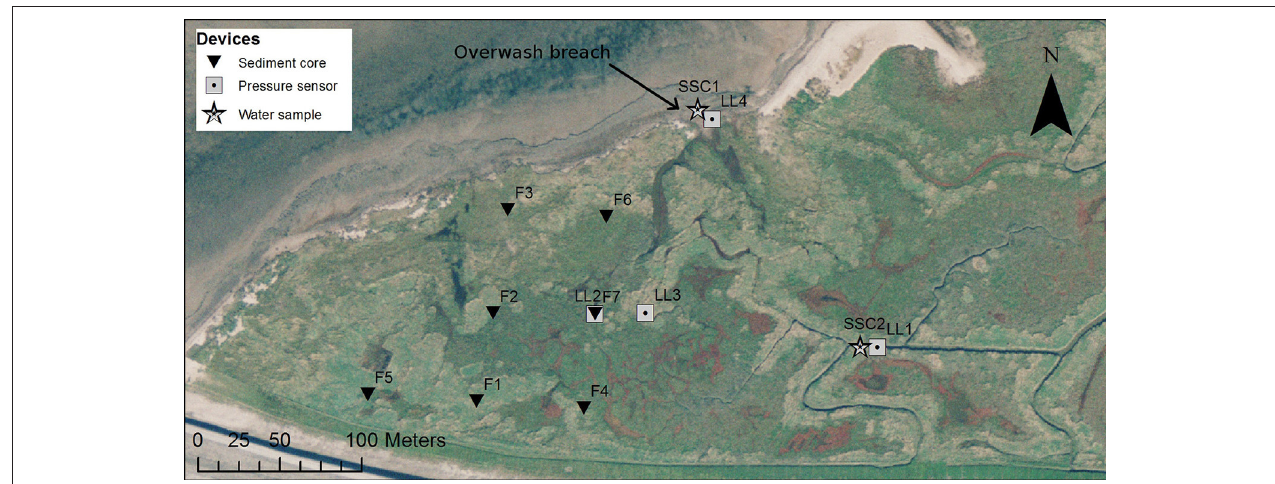
FIGURE 2 | Aerial photograph (from 2010) of the western part of the Oldsumer foreland and locations of sediment cores (F1 to F7), deployed pressure sensors (LL1 to LL4), and water samples collected for analysis of suspended sediment concentrations (SSC1 and SSC2).